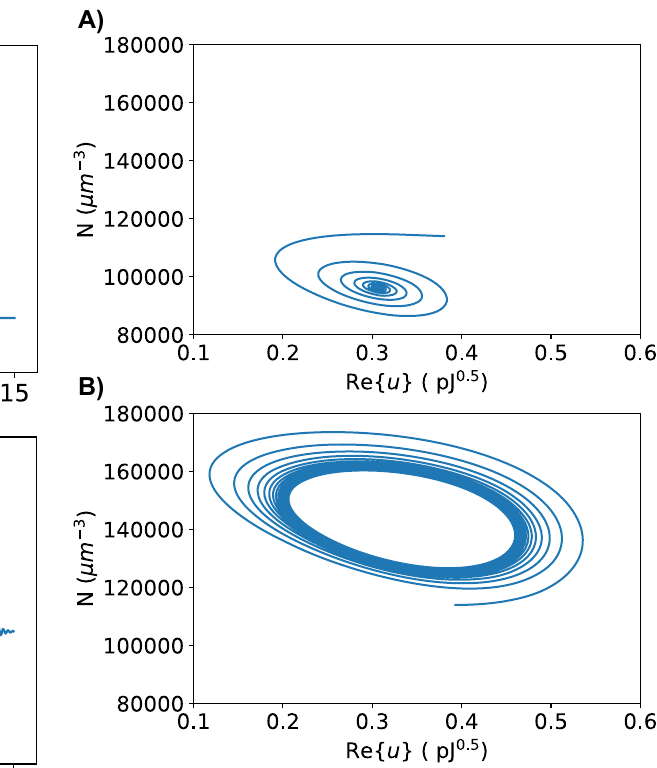
Figure 5: Phase diagram before and after the supercritical Hopf bifurcation. (A) Fermi level is set to 0.4 eV. Oscillations decay to a stable fixed point. (B) Fermi level is set to 0.55 eV. Oscillations are sustained in a stable limit